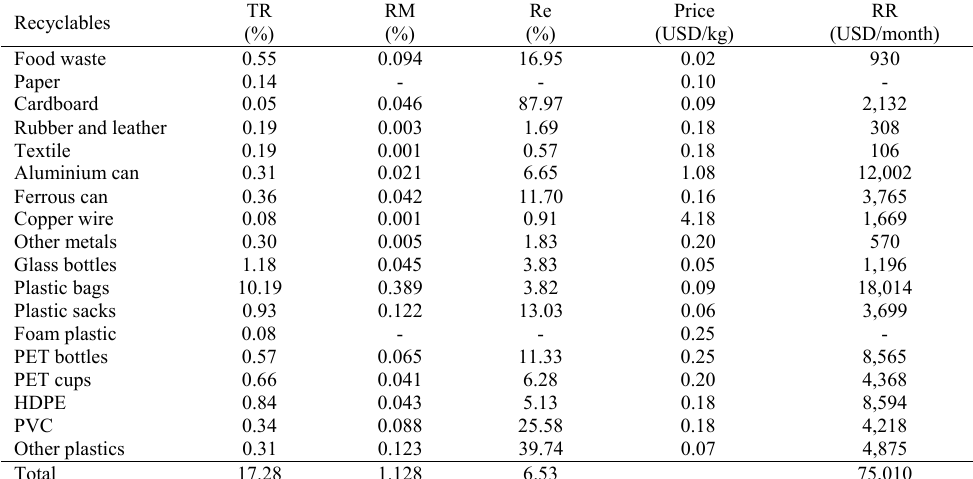
Table 3: Recyclables, recoverability and economic revenues